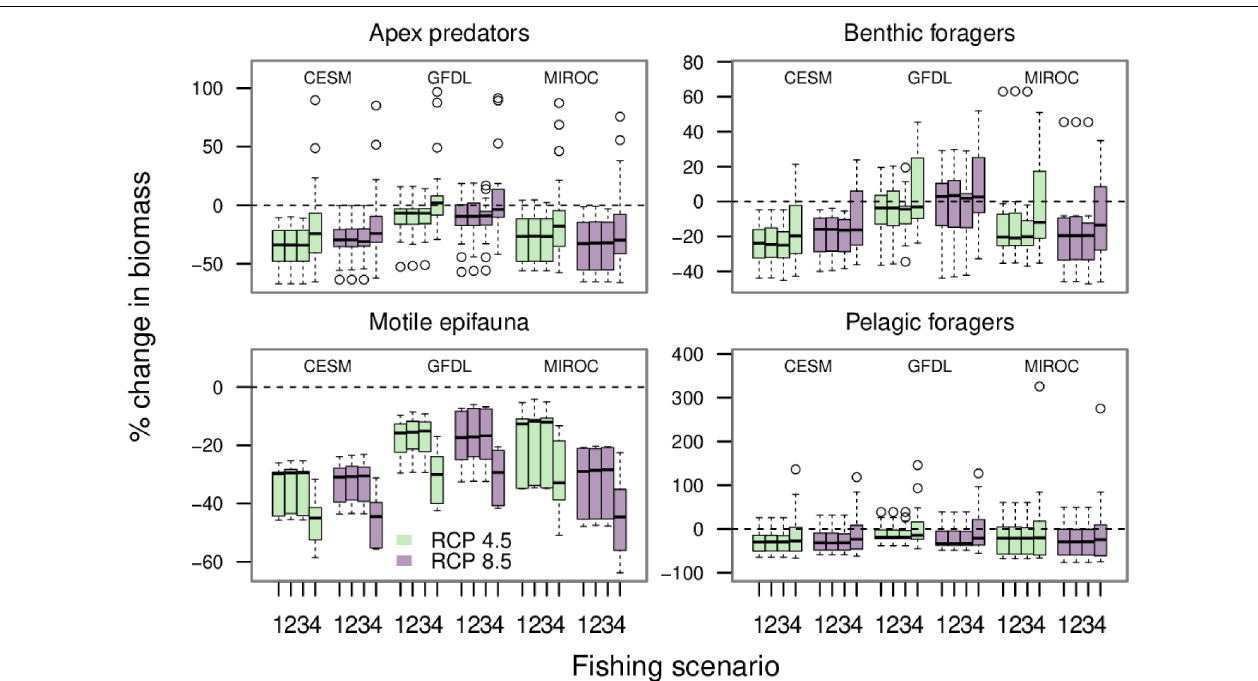
FIGURE 10 | The percent change in biomass for functional groups between the end of the hindcast period (2008–2017) and the end of the projection period for the two RCPs (2071–2080). Each of the four panels is for one of the trophic guilds. Each box-and-whisker shows the percentage change in biomass for all the functional groups within the specified trophic guild by the earth system model-RCP-fishing scenario combination. The earth system models are labeled at the top of each panel. For each earth system model there are two RCPs, 4.5 is shown in green and 8.5 in purple. The fishing scenarios are labeled on the x -axis (1 = status quo , 2 = catch more gadids, 3 = catch more flatfish, 4 = no fishing). Outliers are shown with empty